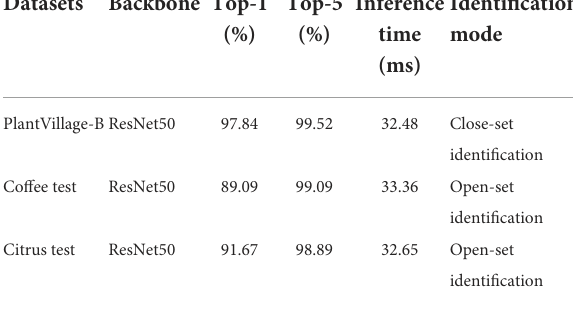
TABLE 5 Performance of our image retrieval system on different test